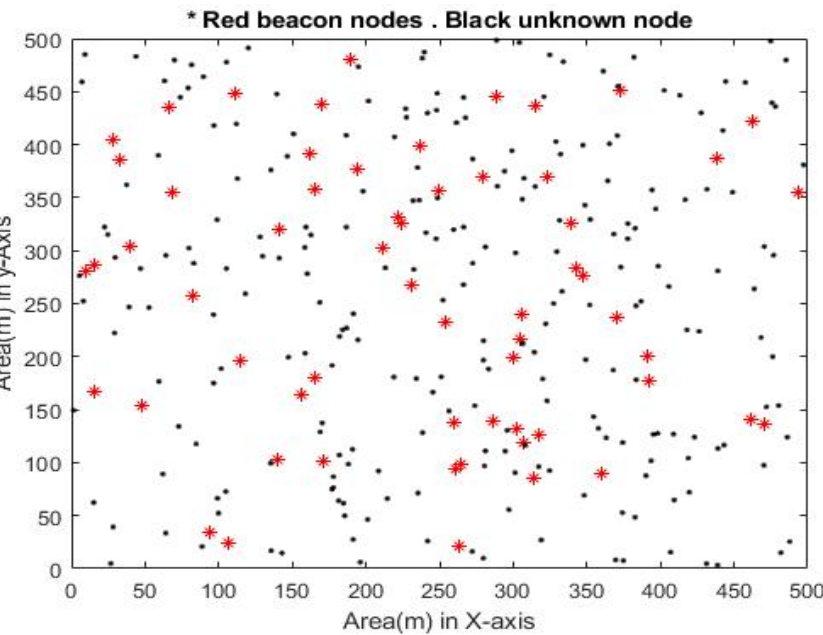
Figure 6. Schematic diagram of randomly generated WSN .